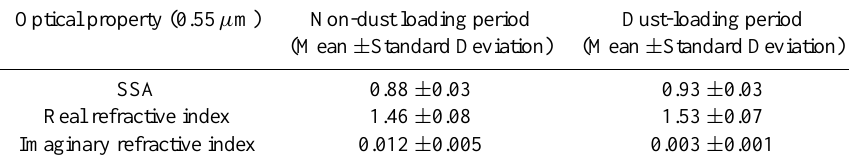
Fig. 5. Aerosol volume size distribution over Kanpur retrieved by AERONET during the winter, pre-monsoon, monsoon and post-monsoon seasons and the annual average in 2004. Enhanced volume concentration at the coarse mode is evident during the pre-monsoon season, whereas the fine mode volume concentration is found to be similar to the annual average. In the other seasons, volume concentration of the coarse mode is far less compared to that in the pre-monsoon season. Table 2. Optical properties in the year 2004 during the non-dust loading and dust-loading seasons over Kanpur retrieved by AERONET. Optical property (0.55 µ